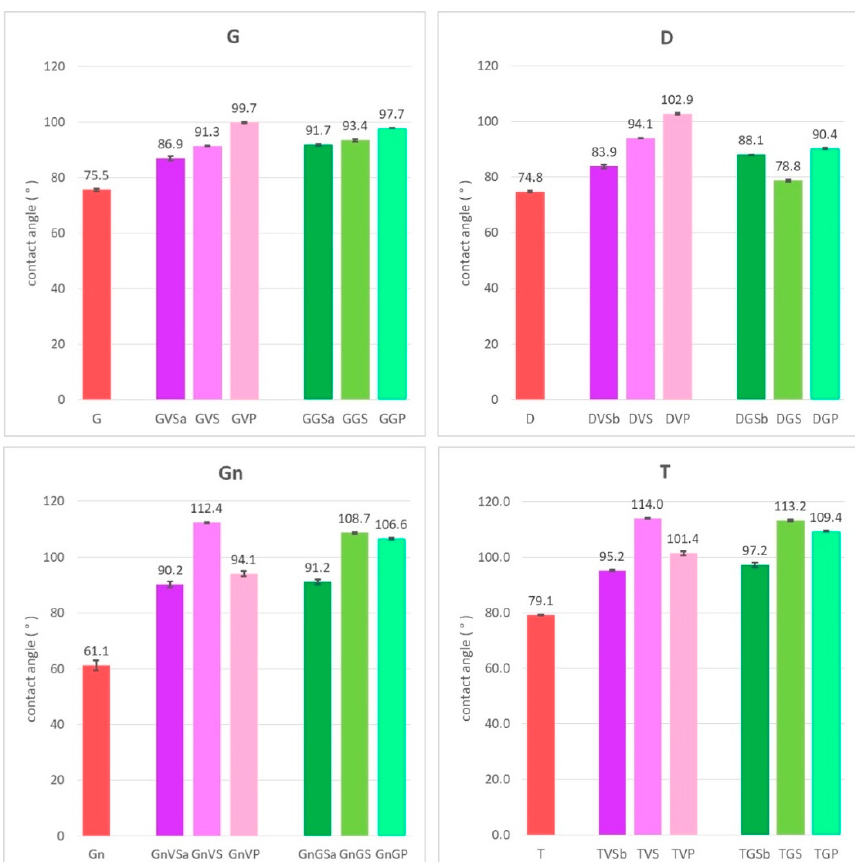
Figure 8. Static contact angle ( θ °) of the uncoated stone and the surfaces coated with either the sacrificial or the permanent anti-graffiti product after being cleaned the respective products. n = 3. Standard deviations are also shown. Check Table 1 for sample labeling.